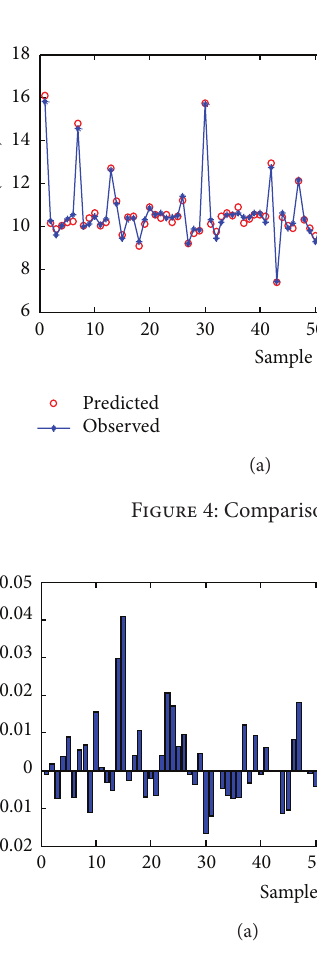
Figure 5: The percentage error of GRNN